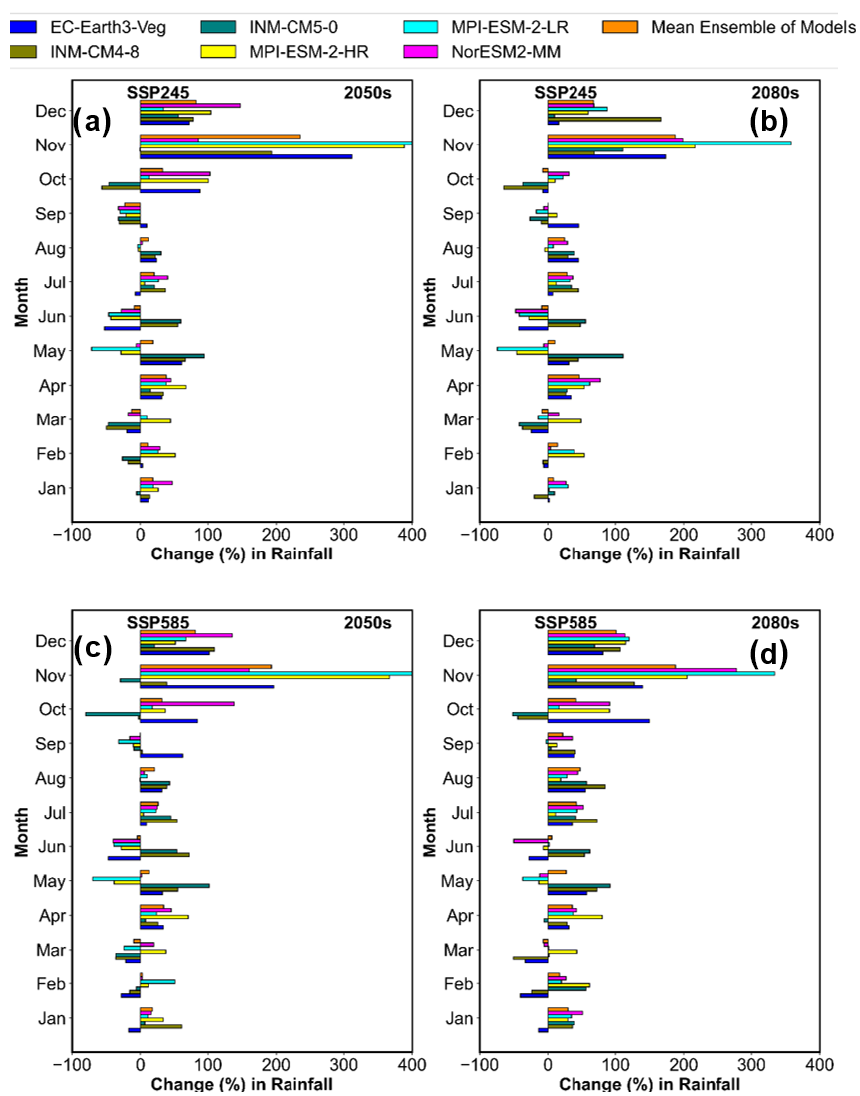
Figure 11. Projected change in the mean monthly rainfall in the sub-basin using different CMIP6 GCMs under the SSP245 and SSP585 scenarios in the (a, c) 2050s and (b, d)